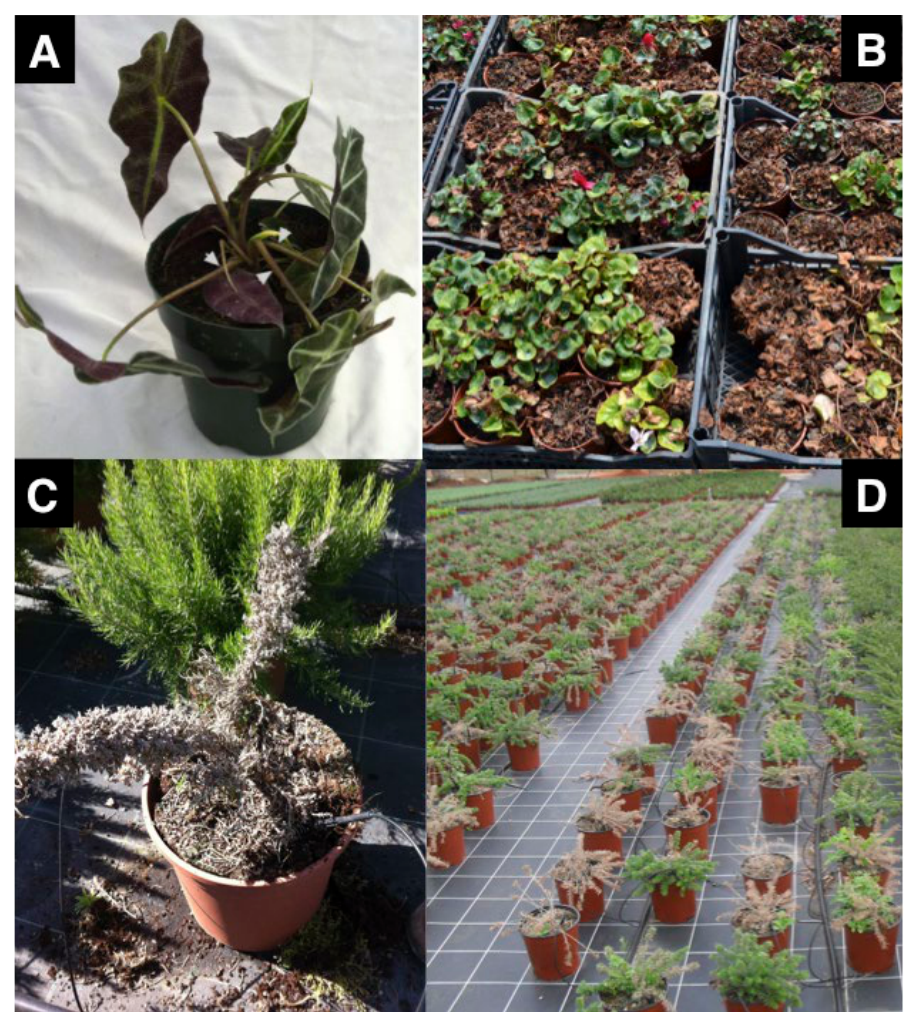
Figure 1. Symptoms associated with Phytophthora nicotianae infection on various hosts. (A) P. nicotianae -infected Alocasia amazonica recovered from an ornamental nursery in Florida. The pathogen initially infects near the collar region leading to the rapid collapse of leaves (indicated by arrows). (B) Disease caused by P. nicotianae on cyclamen. (C) Infected rosemary ( Rosmarinus officinalis ) , and (D) Phytophthora symptoms on Grevillea lanigera . Both P. nicotianae and P. cinnamomi were recov- ered from these diseased